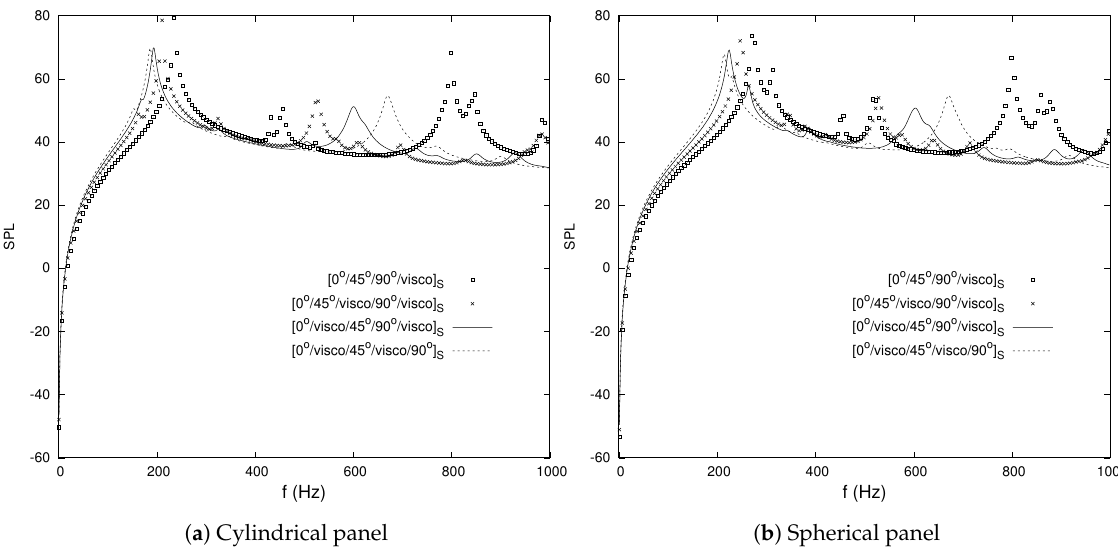
Figure 12. Transmitted sound power level ( SPL ) of the composite cylindrical and spherical shells with different viscoelastic layer sequences.